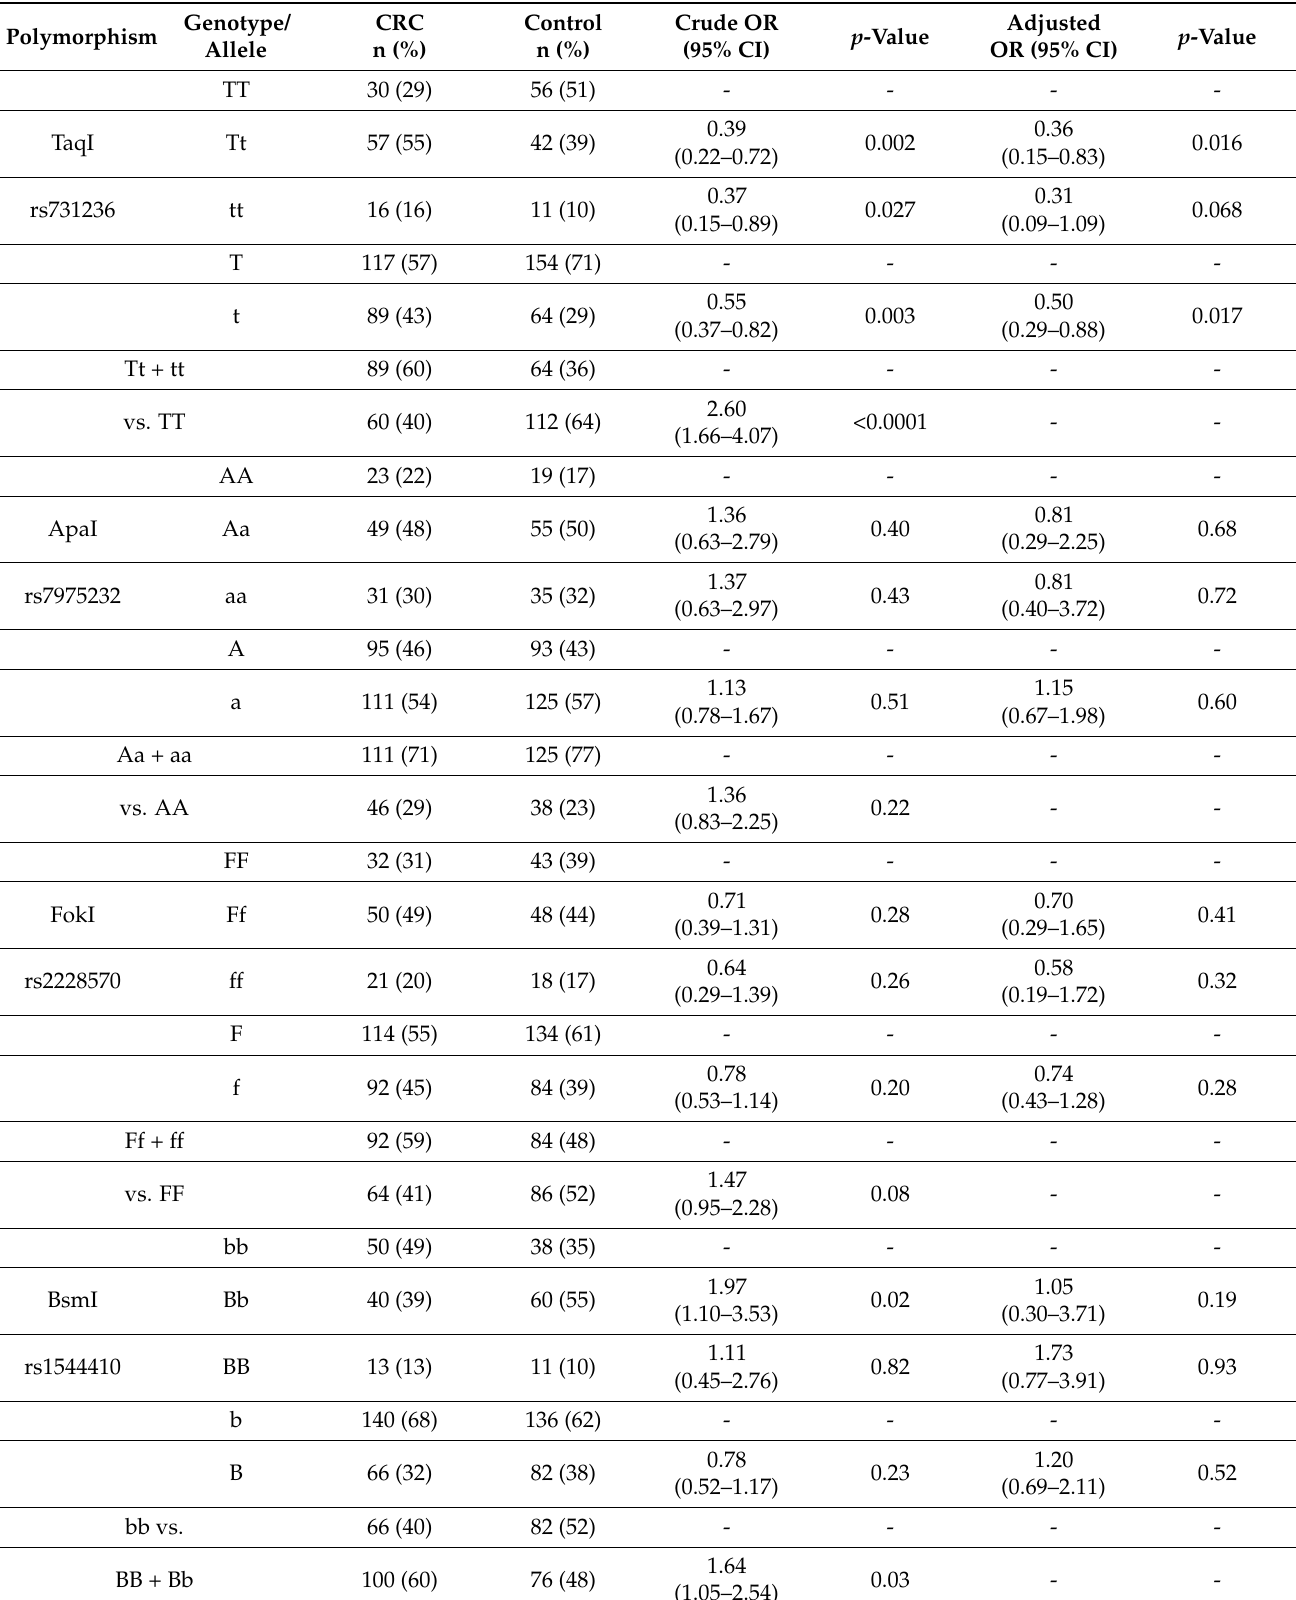
Table 5. Genotype and allele frequencies of VDR polymorphisms in CRC and control